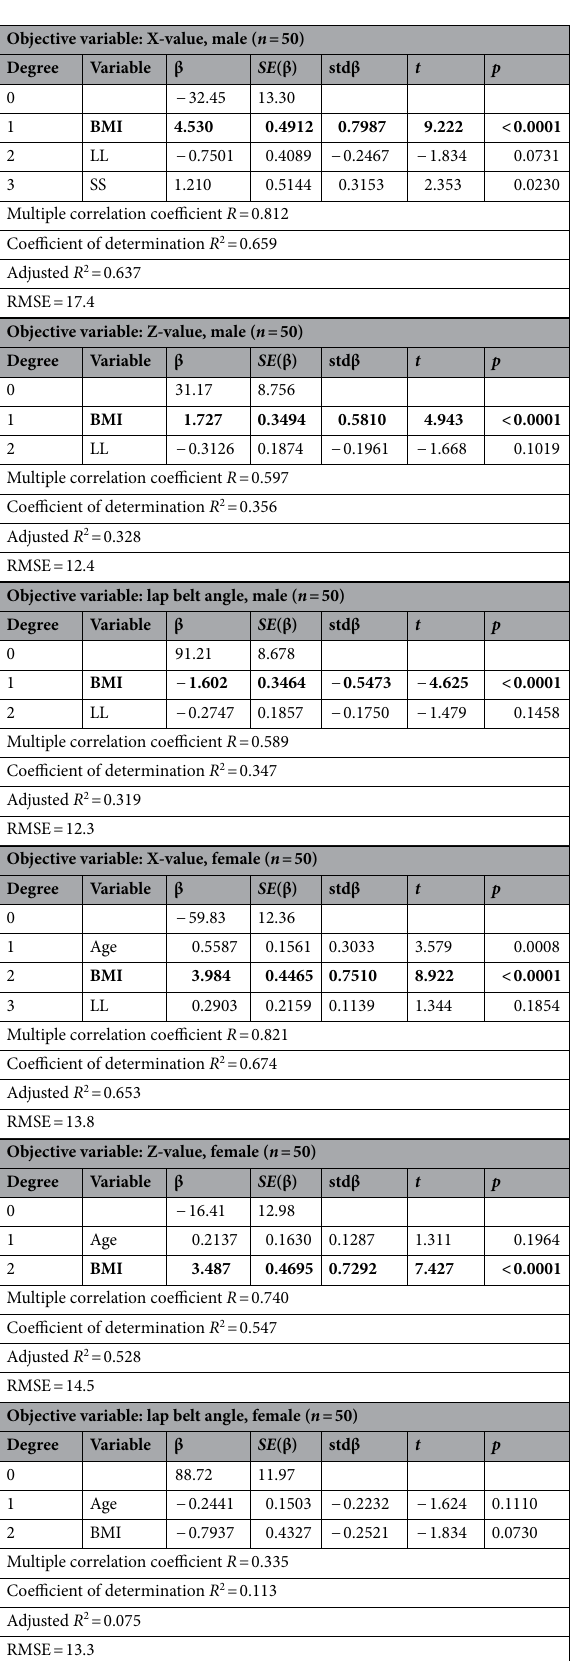
Table 3. Multiple regression analysis using the stepwise method are shown (β: partial regression coefficient, SE (β): standard error of β, stdβ: standardized partial regression coefficient). Significant values are in